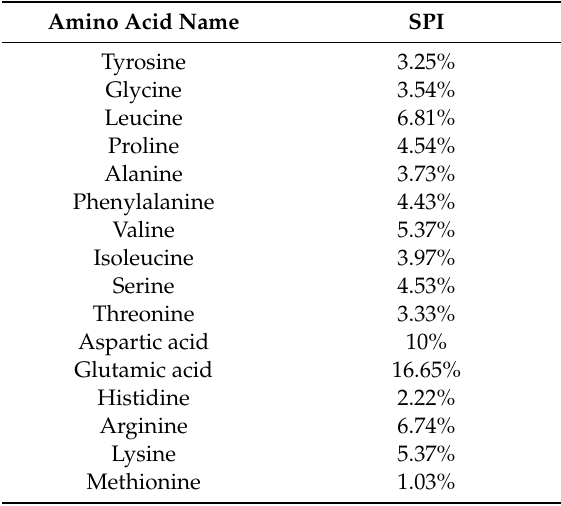
Table 1. The amino acid content of